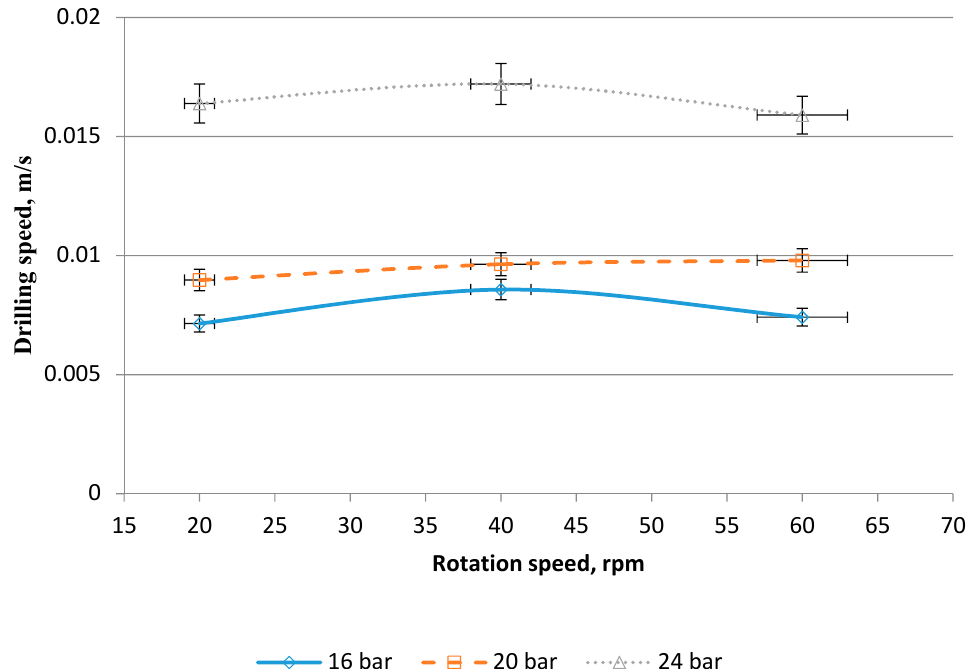
Figure 10. Variation of drilling velocity with rotation speed for several pressures (shown in the legend below the figure), for the 127 mm diameter drill bit, an interval of 90 to 108 m below the ground level, and boreholes 4–6.